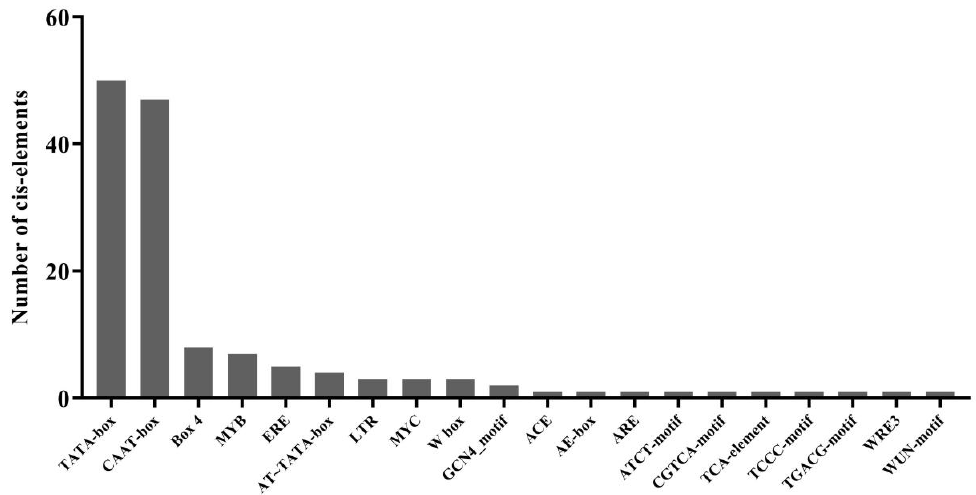
Figure 2. Statistics of cis-elements in promoters of GhNAC82 .